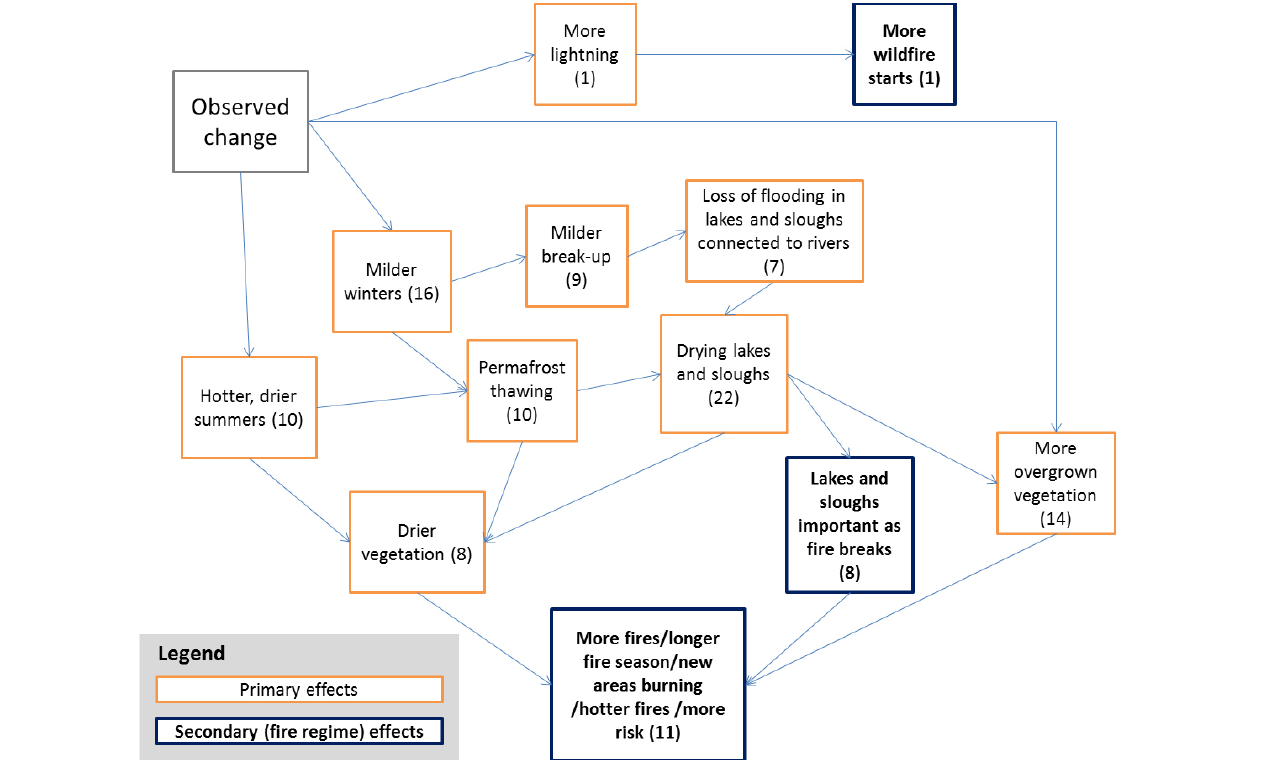
Fig. 3 . Koyukon respondent observations of changes in landscape and climate influencing wildfire regime. Note that the numbers in parentheses refer to the number of respondents who provided that